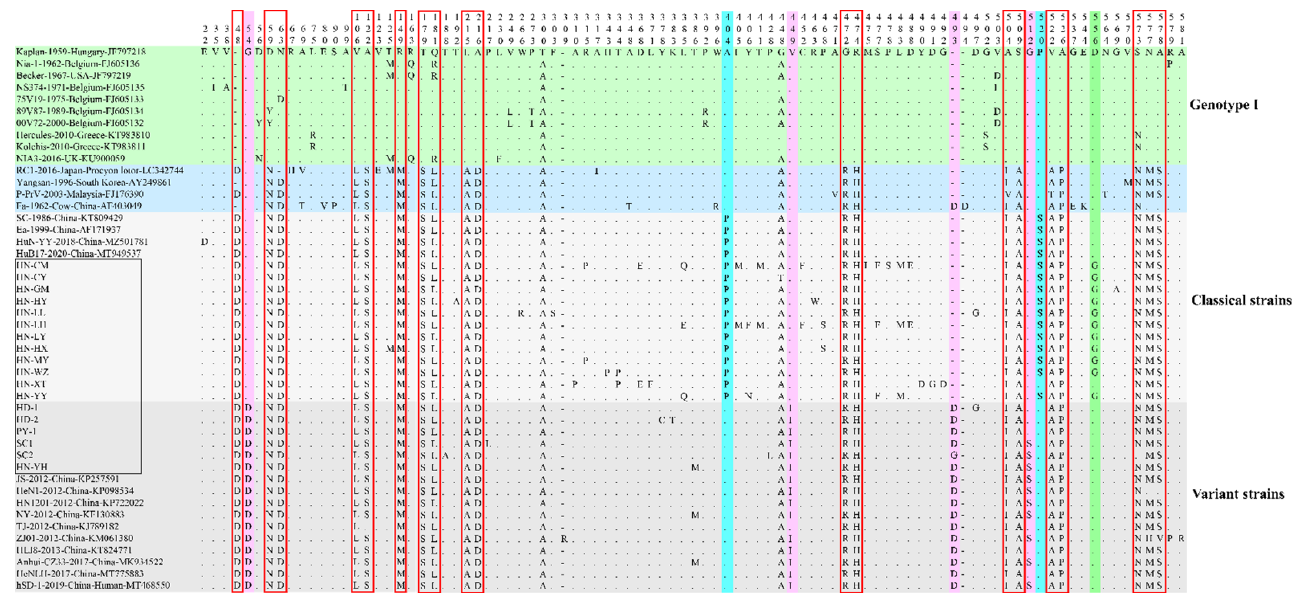
Figure 4. All amino acid mutation sites of gE protein of 18 PRV isolates sequenced in this study and 28 reference strains. All the strains were clustered into two genotypes, and genotype I only contained European–American PRV strains (mint green), while genotype II included Chinese variant strains (cloud gray), Chinese classical strains (pearl river gray) and Asian strains (Maya blue). The PRV isolates acquired in this study are shown in the hollow black rectangle. Compared with genotype I strains, unique amino acids substitutions of genotype II strains are shown in the hollow red rectangles. Amino acid mutations in variant strains are highlighted in lavender violet. The arctic blue areas represent unique amino acids substitutions in classical PRV strains. The screamin’ green area represents unique amino acid substitutions in classical PRV strains from the Henan province.